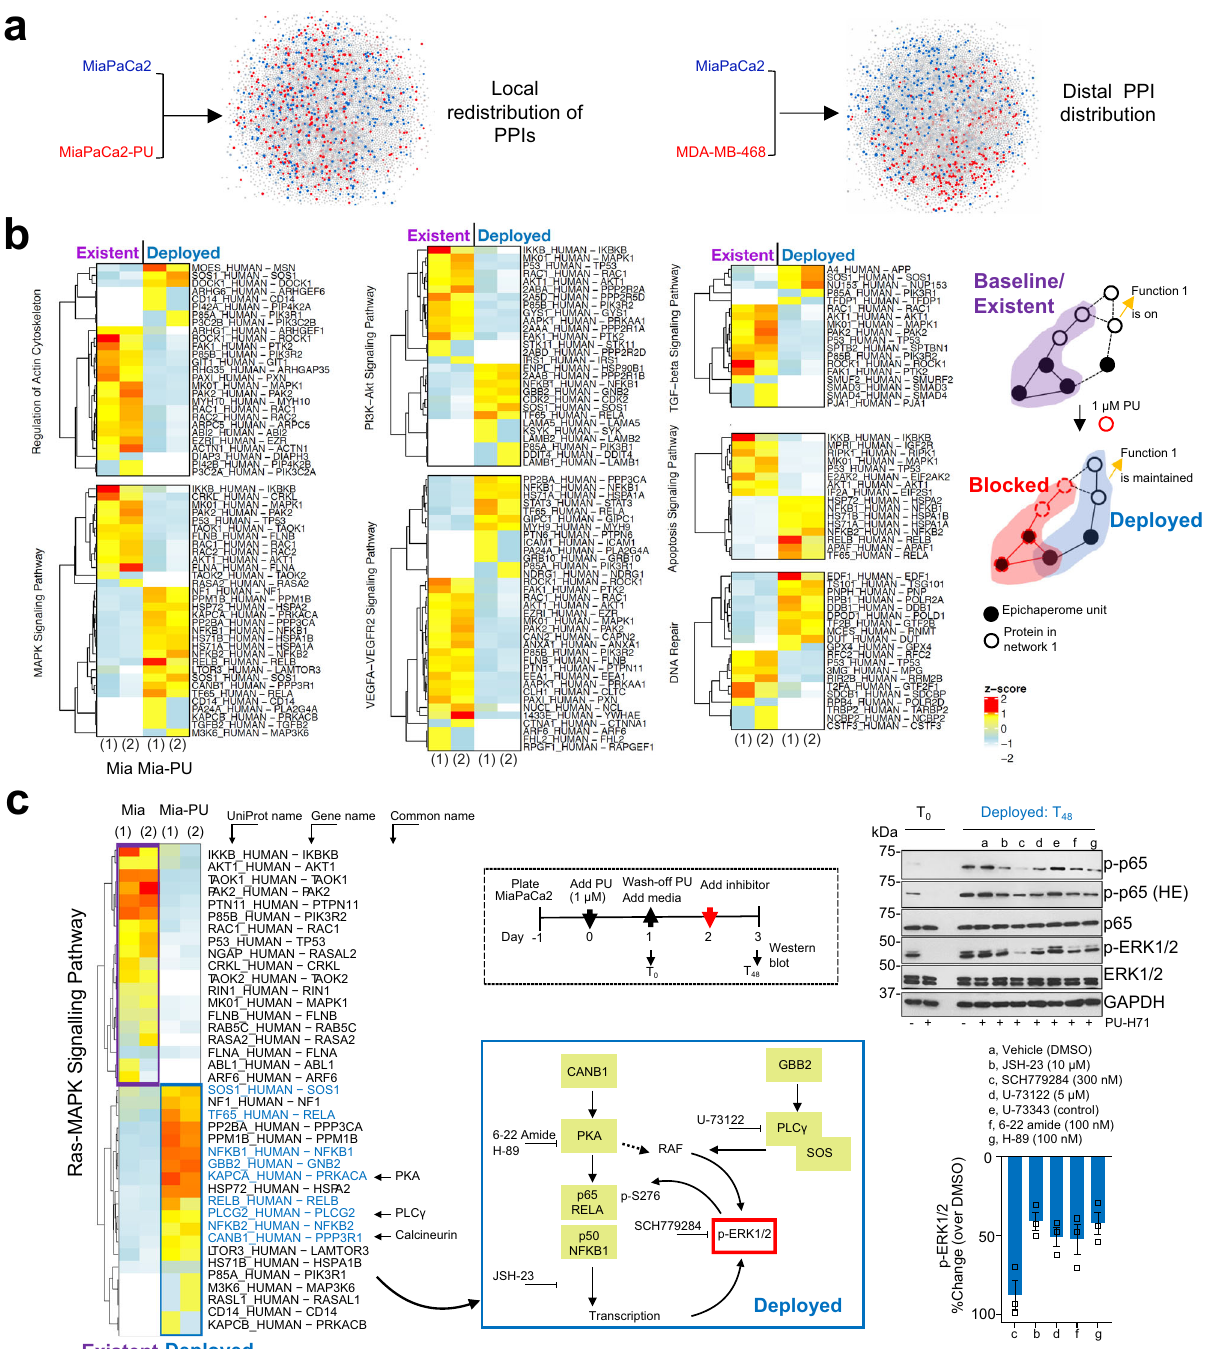
Fig. 4 Cells forced into a state of interactome hyperconnectivity retain the activity of protein pathways already existent, and constitutively active, at baseline. a Comparative analysis of PPI distribution. Left side map: blue, indicating proteins that establish interactions unique to baseline (MiaPaCa2) and red, unique to recovery (MiaPaCa2-PU). Right side map: red, unique to MDA-MB-468 vs blue, unique to MiaPaCa2. The node size and node colour represent the log10 transformed p-values and the fold change values, respectively, from the DC analysis (see Fig. 3a). Network edges and node labels were omitted for fi gure clarity. b Heatmaps showing proteins of key pathways activated in pancreatic cancer that interact with epichaperomes at baseline (existent, MiaPaCa2) and at recovery (deployed, MiaPaCa2-PU), as determined by epichaperomics. Each column is an experimental repeat. See Fig. 3a for experimental design. The right-side schematic shows the mechanism by which epichaperomes remodel PPIs to maintain, in conditions of interactome hyperconnectivity, the activity of protein pathways constitutively active at baseline. c Proof-of-principle validation of alternate paths deployed to retain a hyperactive ERK in conditions of induced network hyperconnectivity. Drugs were added as indicated in the schematics. Error bars mean ± SEM of n = 3 independent experiments. HE high